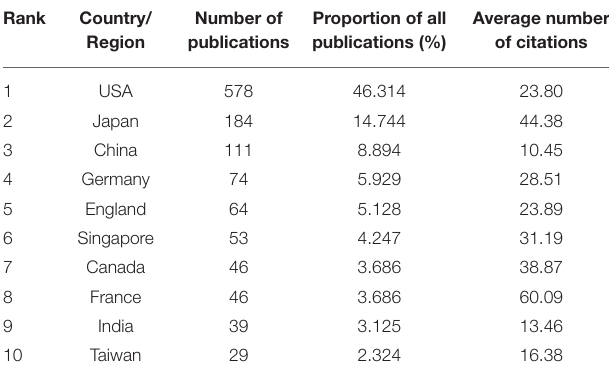
TABLE 2 | Numbers of publications, the proportion of all publications, and the total number of times the top 10 countries or region are cited and ranked by the number of publications based on WOS.